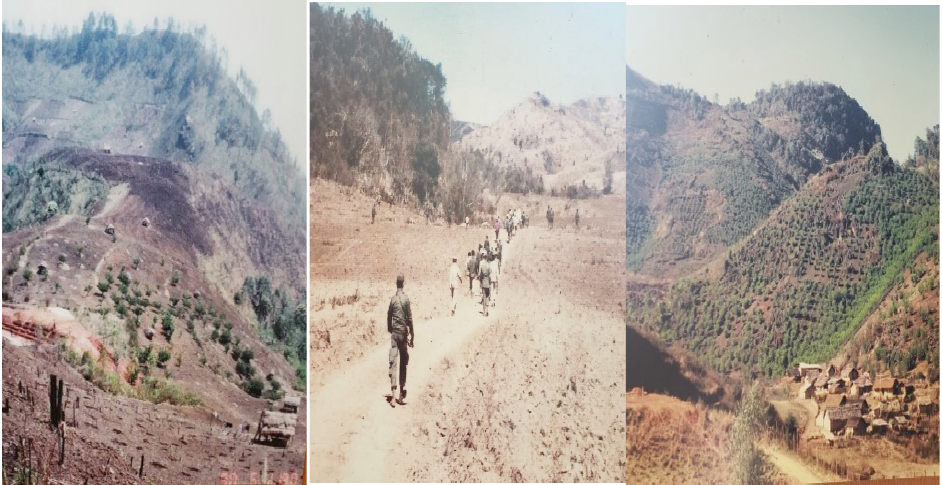
Note. Images collected from the Doi Angkhan Development Study Center.